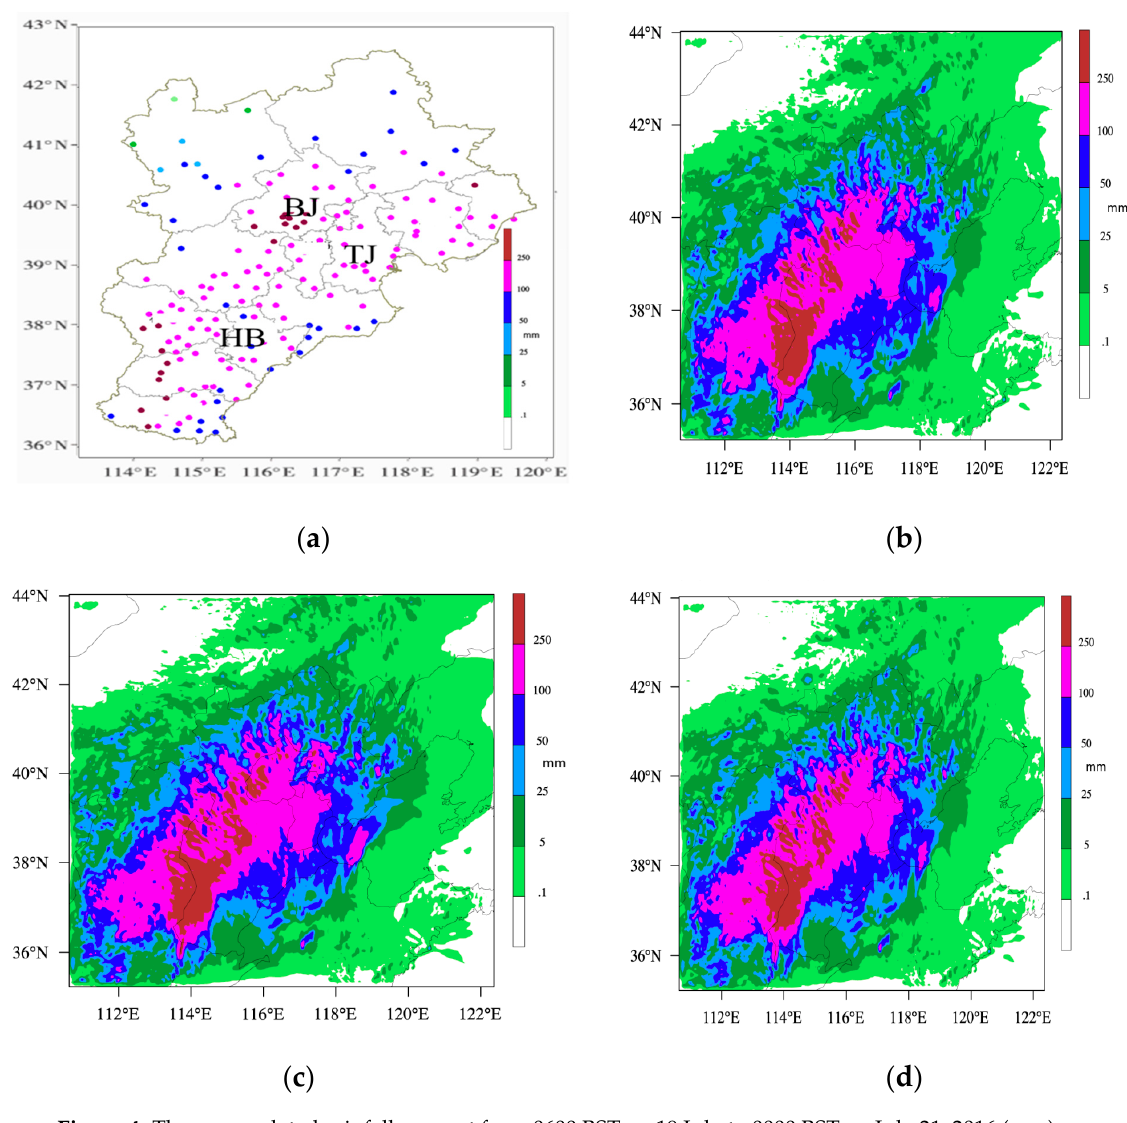
Figure 4. The accumulated rainfall amount from 0600 BST on 19 July to 0000 BST on July 21, 2016 (mm). ( a ) Observation, ( b ) CTL test, ( c ) clean test, and ( d ) polluted test.